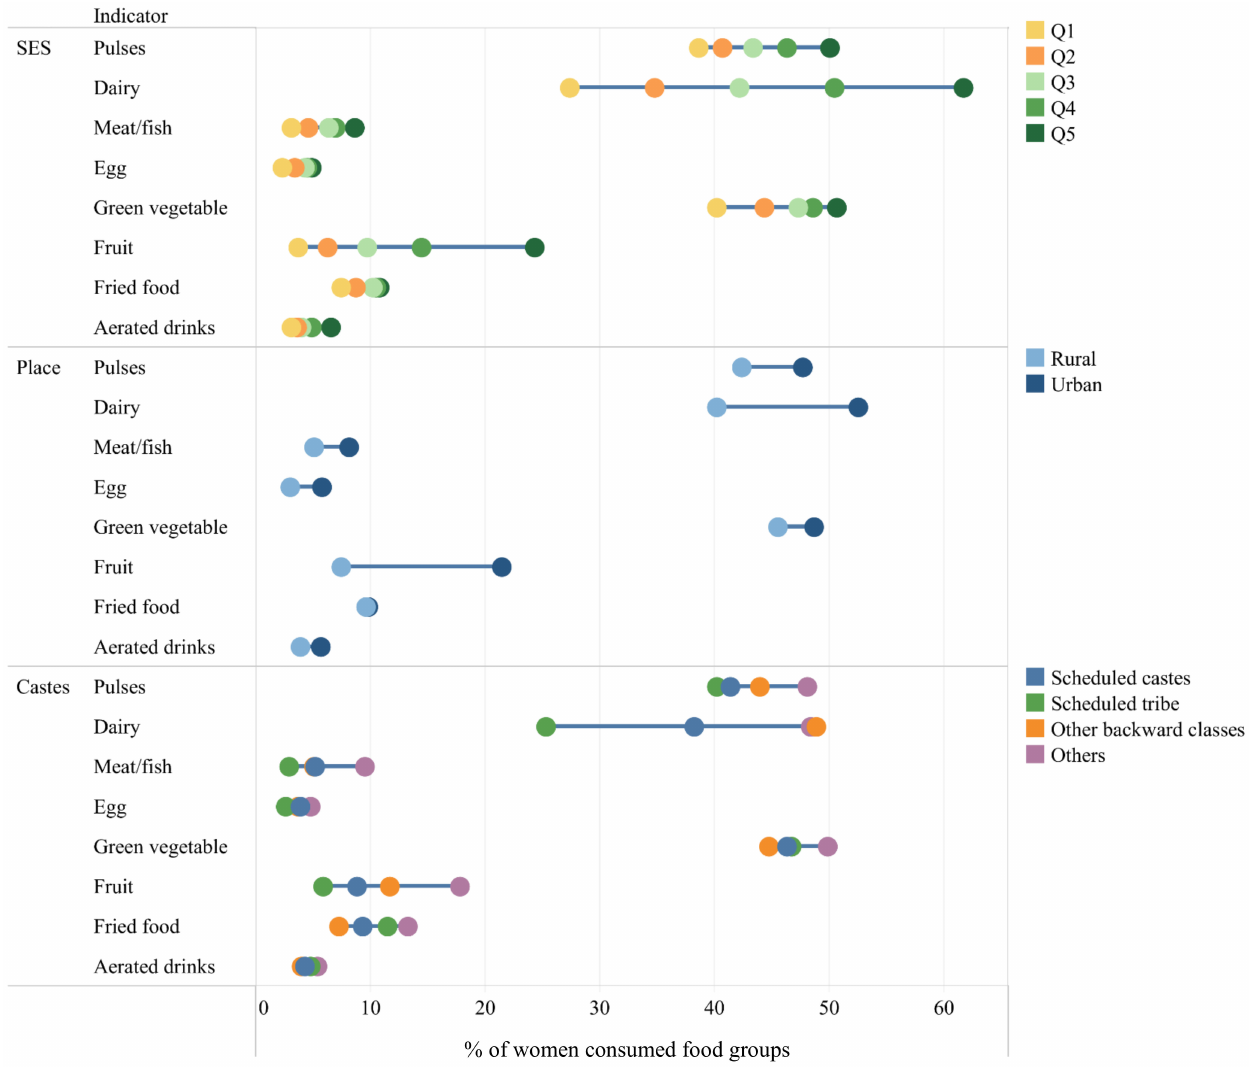
Figure 2. Socioeconomic 1 , residential, and caste inequality in dietary intake among Indian pregnant women. SES: socioeconomic status; Q: quintile. Data are from National Family Health Survey 2015–2016. 1 Household SES was constructed using the principal component analysis method. The first principal component was used to divide household SES into quintiles; the lowest quintile (Q1) represented the poorest 20% of the population and the highest quintile (Q5) represented the richest